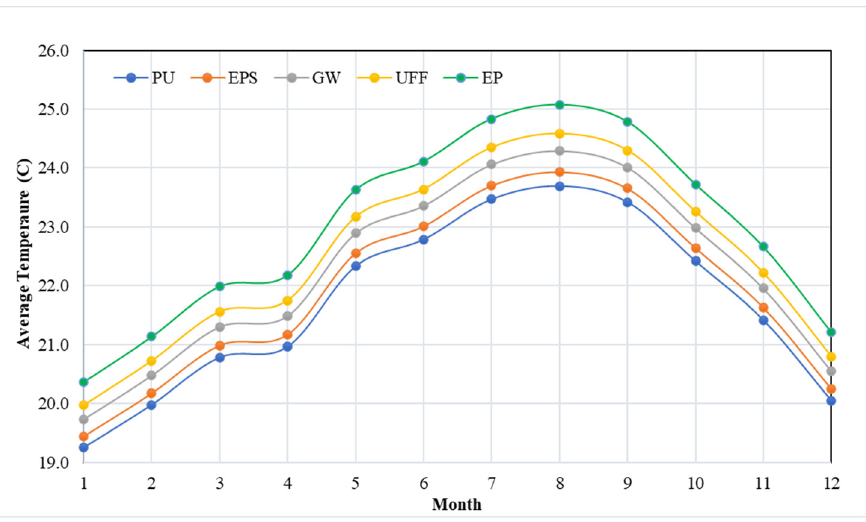
Figure 10. Average monthly indoor temperature variation for various insulation options.